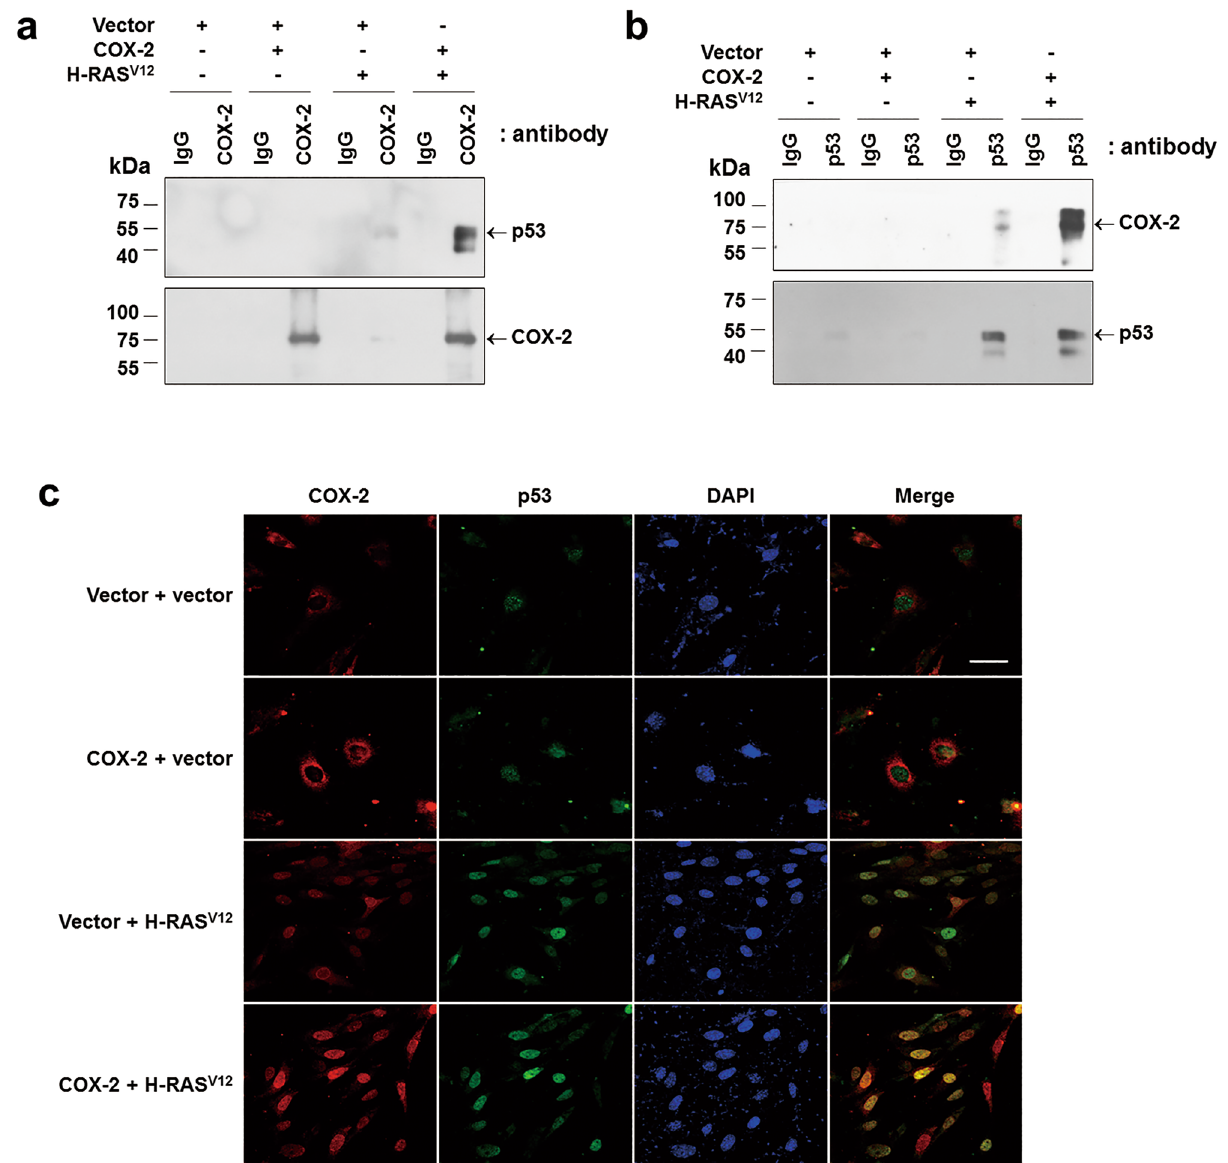
Figure 5. COX-2 interacts with p53 in the nucleus under oncogenic RAS activation. ( a , b ) MEFs were infected with retroviruses as indicated. Cell lysates were subjected to immunoprecipitation assays using an anti-COX-2 antibody ( a ) and an anti-p53 antibody ( b ). ( c ) Confocal microscopy was performed using an anti-COX-2 antibody (red), an anti-p53 antibody (green), and DAPI (blue). Merged images of red and green channels were also shown. Scale bar = 50